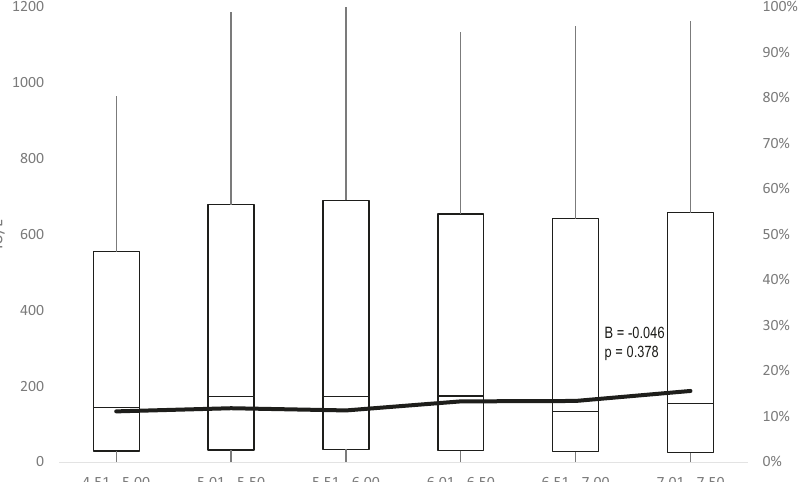
Fig. 3 Long-term anti-HBs titre (boxplot, left y axis) and proportion of individuals below 10 IU/l (black line, right y axis) by time interval (months) between the administration of the second and the third dose in the Cohort